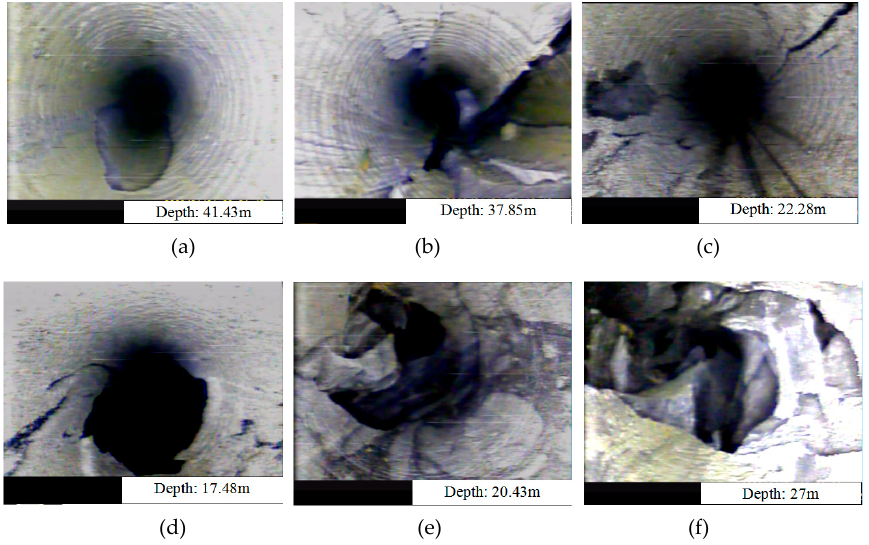
Figure 15. Drilling peep results of the station I: (a) the horizon of 24.4 m; (b) the horizon of 22.1 m; (c) the horizon of 6 m; (d) the horizon of 4.8 m; (e) the horizon of 9.3 m; (f) the horizon of 16.2 m.